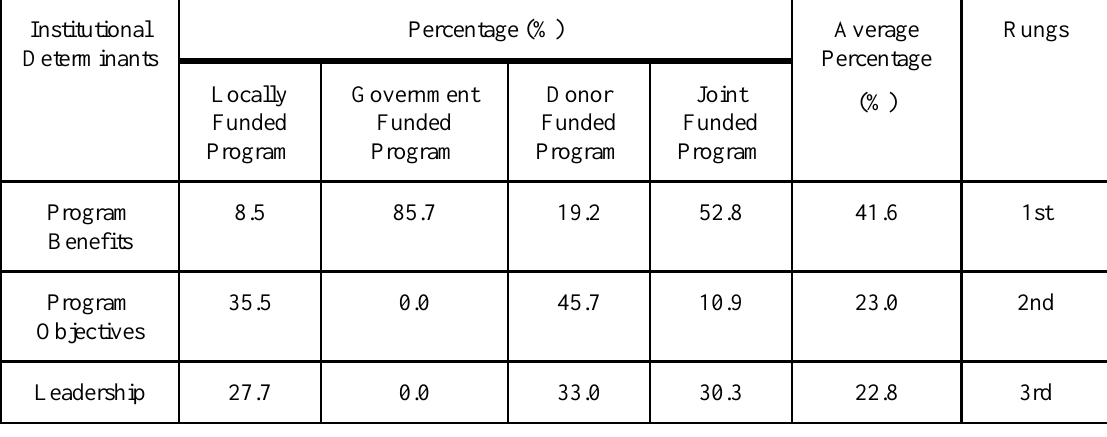
Table 1. Average score for Key Cited Institutional